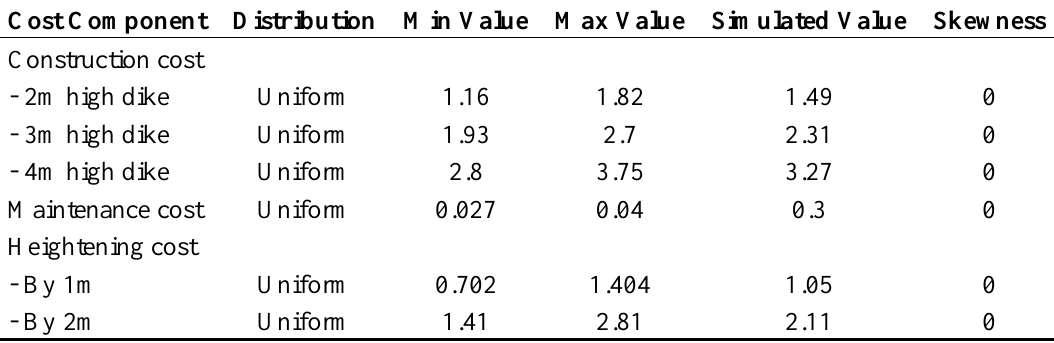
Table A8. Simulation results, dike costs, CBA analysis.